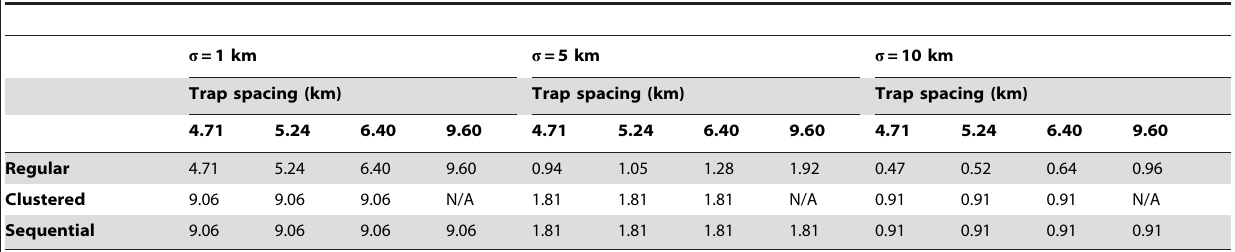
Table 2. Effective trap spacings for each s , scaled by dividing trap spacings (4.71, 5.24, 6.40, and 9.60 km) by s (1, 5, 10